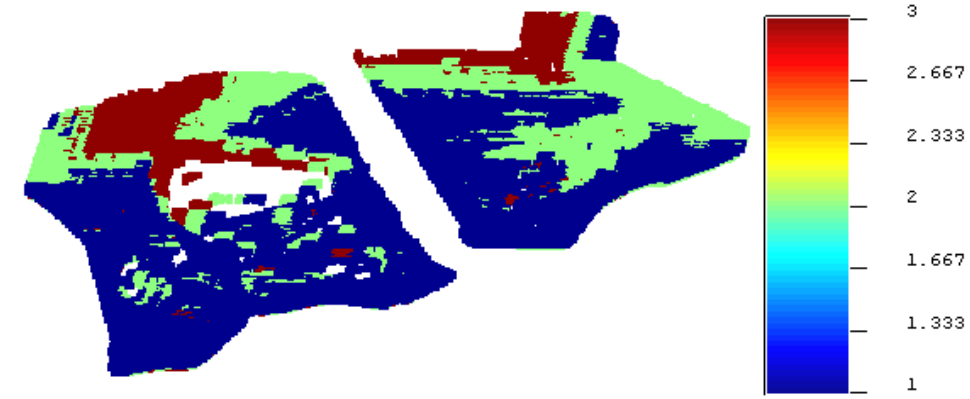
Figure 8. Model 1 the final ultimate pit of the feasible solution (legend represents a period of extrac- tion).